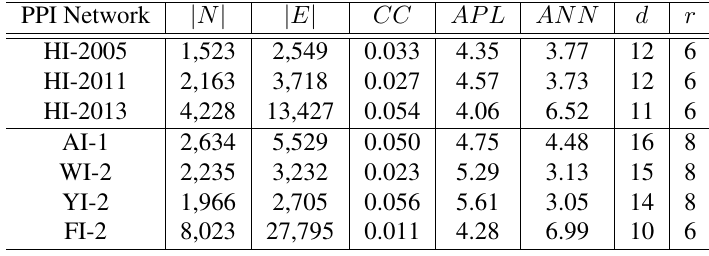
Table 1: Basic network properties of the analysed PPI networks. The column labels are as fol- lows: | N | , number of nodes; | E | , number of edges; CC , clustering coefficient; APL , avarage path length; ANN , average number of neighbours; d , diameter; and r ,